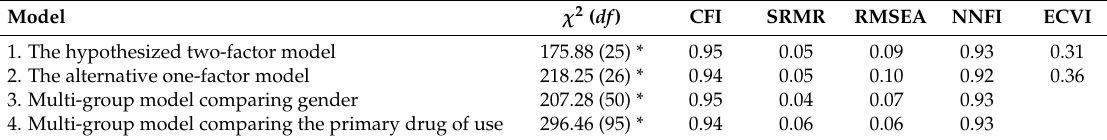
Table 4. Confirmatory factor analysis of the Addiction Memory Intensity Scale (AMIS; n = 710). Model